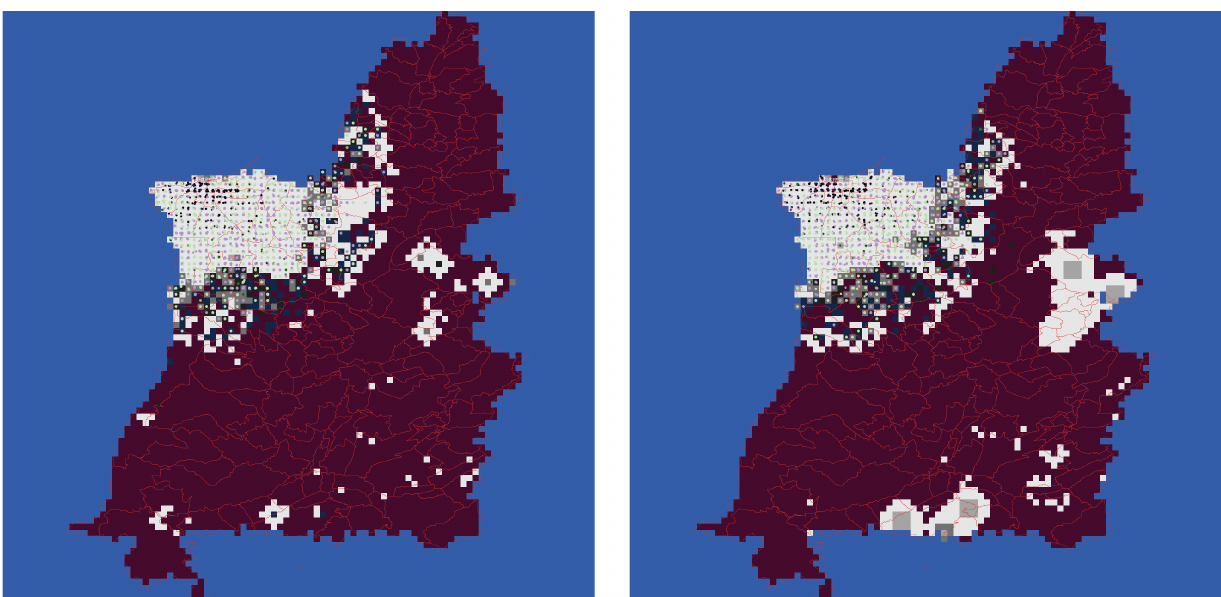
Figure 7. Effect of housing reconstruction aid, seen eight years after the explosion (left); effect of structural aid to the property market seen at same time point